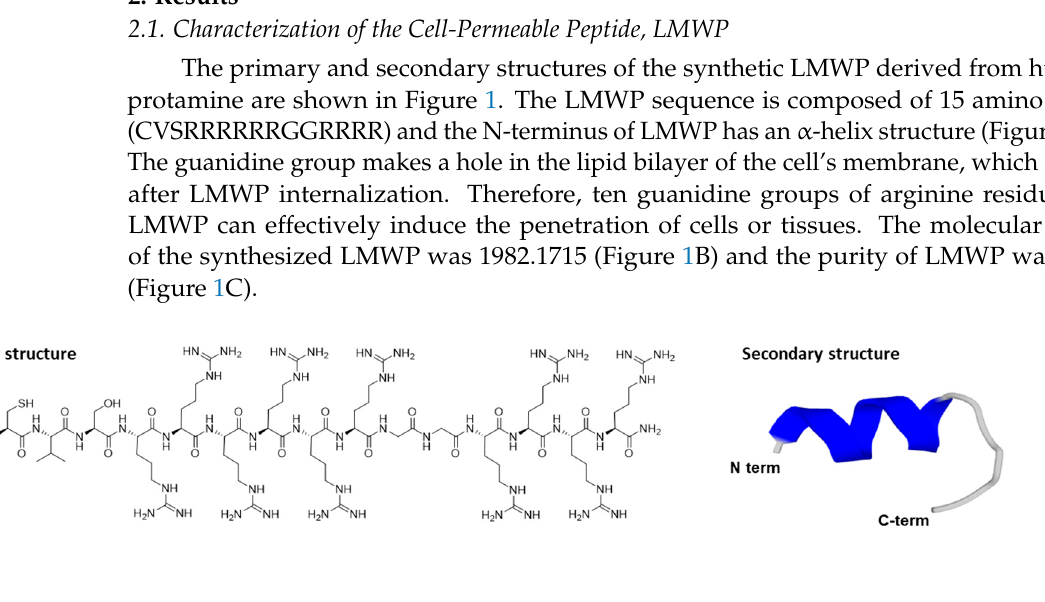
Figure 1. Synthesis of the LMWP cell-permeable peptide. ( A ) The primary and secondary structure of LMWP. ( B ) Sequence information of the synthesized LMWP. ( C ) HPLC chromatogram peak and mass value of LMWP. 2.2. Characterization of the Oct4-LMWP Complex The Oct4 -LMWP complexes with different molar ratios with LMWP (N:P = 1:1, 1:2, 1:3, 1:5, and 1:10) were formulated and applied for measuring their surface charge and size. The distribution of the mean zeta potential and particle size diameter of Oct4 -LMWP complexes were determined for each of the five tested ratios (Figure 2). The apparent zeta potential distribution of Oct4 DNA was − 17.8 ± 8.2 mV (Figure 2A). The Oct4 -LMWP com- plexes had zeta potential distributions of − 28.6 ± 5.4 mV (N:P = 1:1), 29.2 ± 5.3 mV (N:P = 1:2), 39.0 ± 5.0 mV (N:P = 1:3), 43.9 ± 4.6 mV (N:P = 1:5), and 47.1 ± 5.8 mV (N:P = 1:10), respectively. The zeta potential of the Oct4 DNA increased to 47.1 ± 5.8 mV when in a complex formation with LMWP. The mean particle size of the Oct4 -LMWP complex was decreased to less than 200 nm, which was significantly smaller than that of native Oct4 DNA (407.4 ± 1.0 nm; Figure 2B).